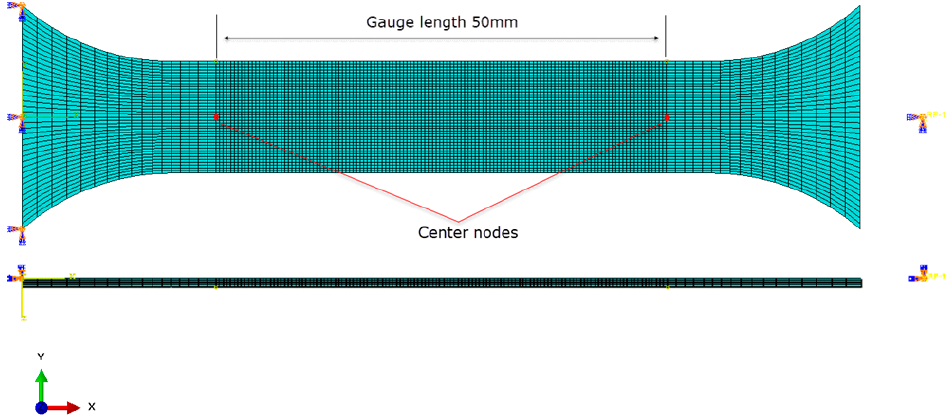
Figure 8. Mesh on the specimen.